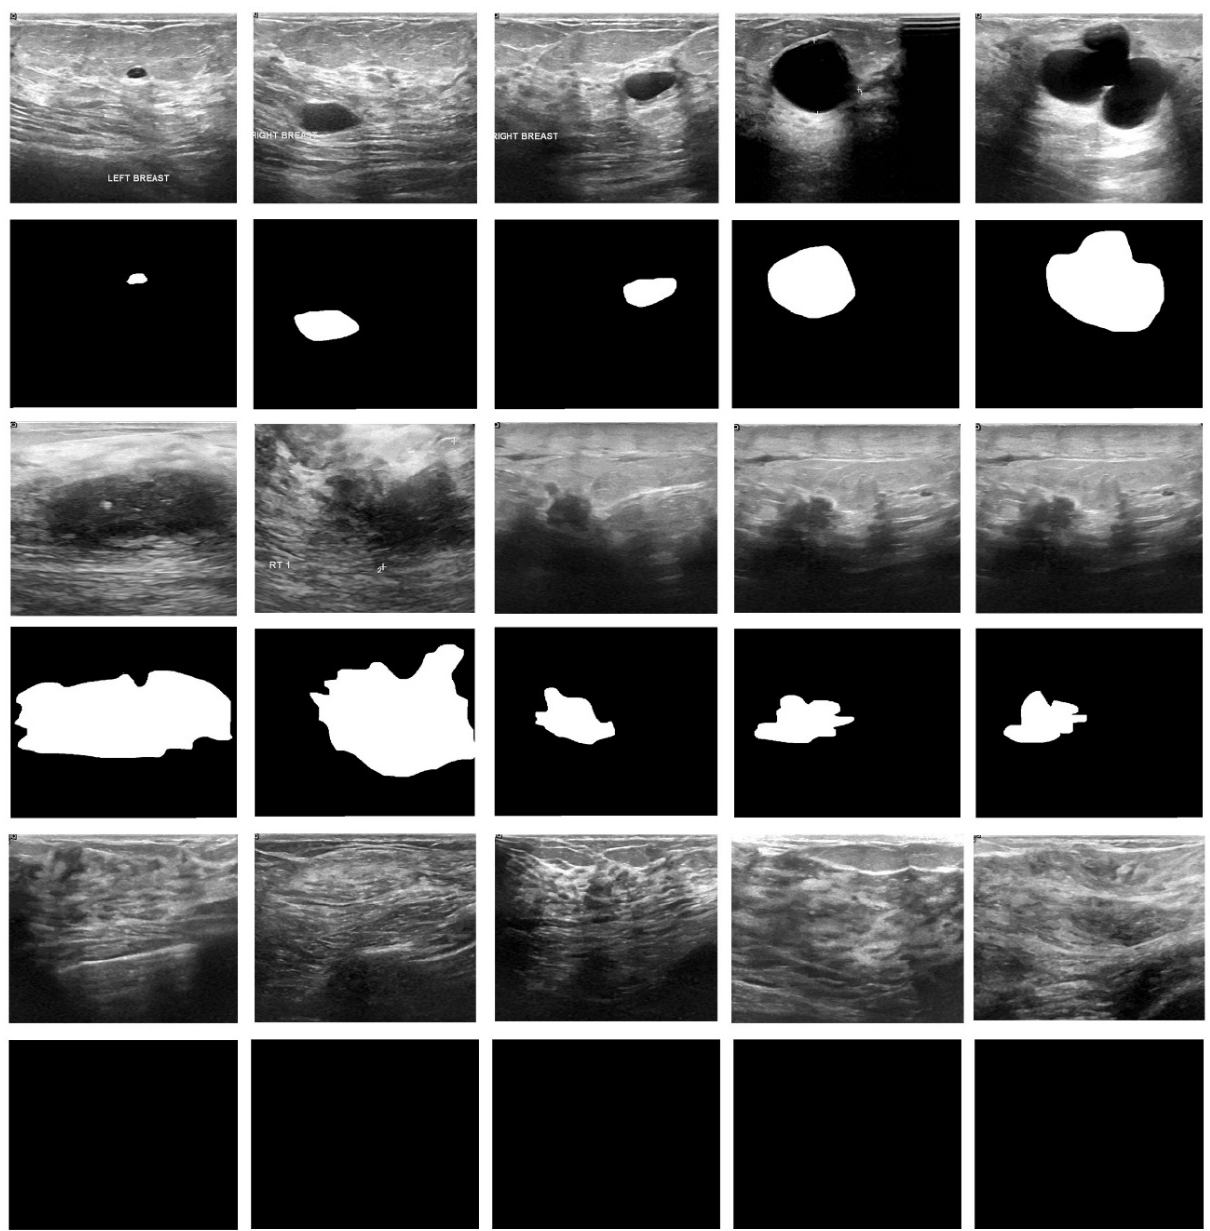
Figure 3. Sample and ground truth images (benign/malignant/normal).